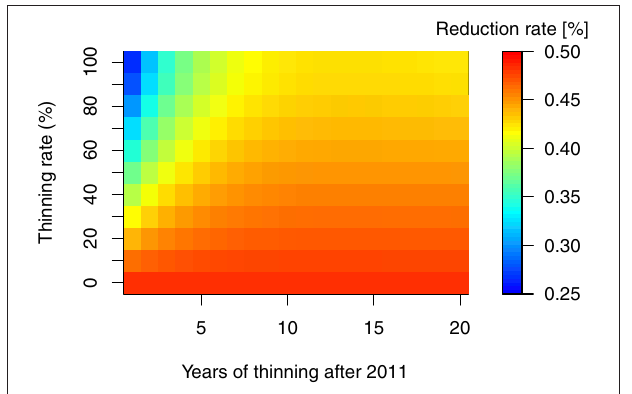
FIGURE 5 | Reduction rate in percent total 137 Cs inventory, 30 years after the fallout event, for thinning at various rates and timing.